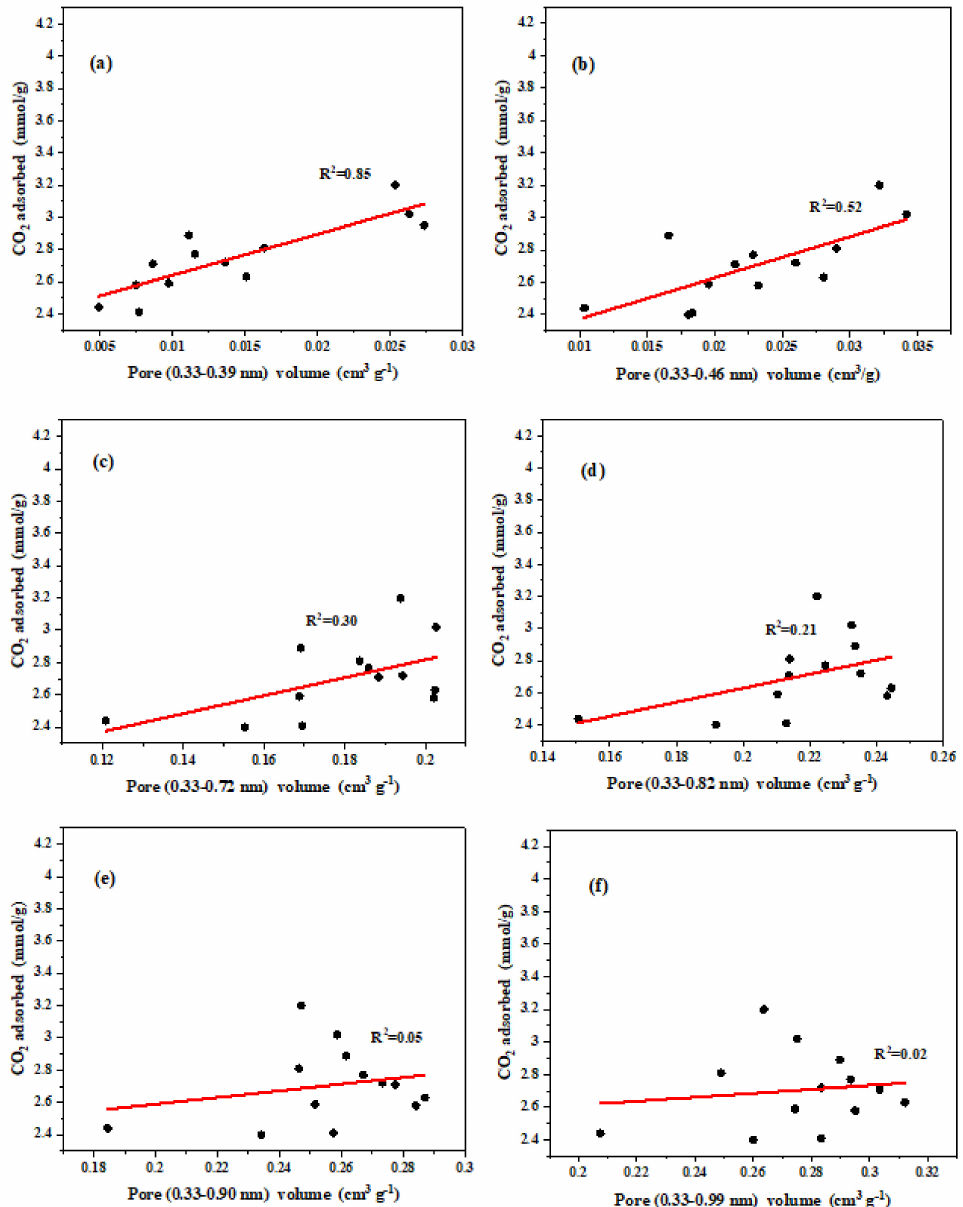
Figure 9. Relationship between CO 2 adsorption at 298 K and the volume of micropores in the range of ( a ) 0.33 − 0.39 nm, ( b ) 0.33 − 0.46 nm, ( c ) 0.33 − 0.72 nm, ( d ) 0.33 − 0.82 nm, ( e ) 0.33 − 0.90 nm, and ( f ) 0.33 − 0.99